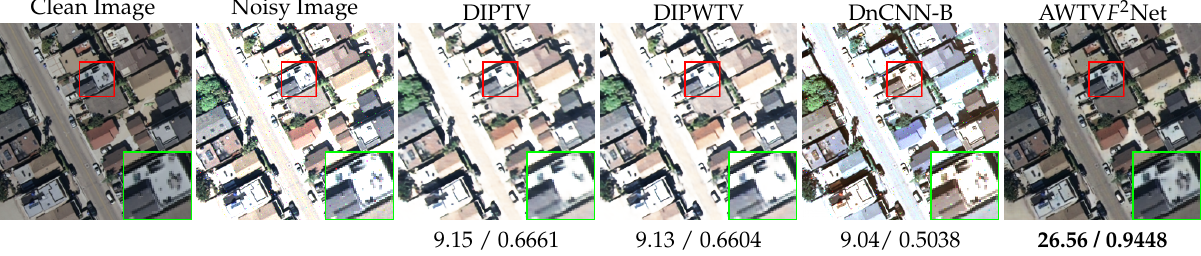
Figure 20. Enlarged details of the ‘Dense residential’ image with the third type of mixture